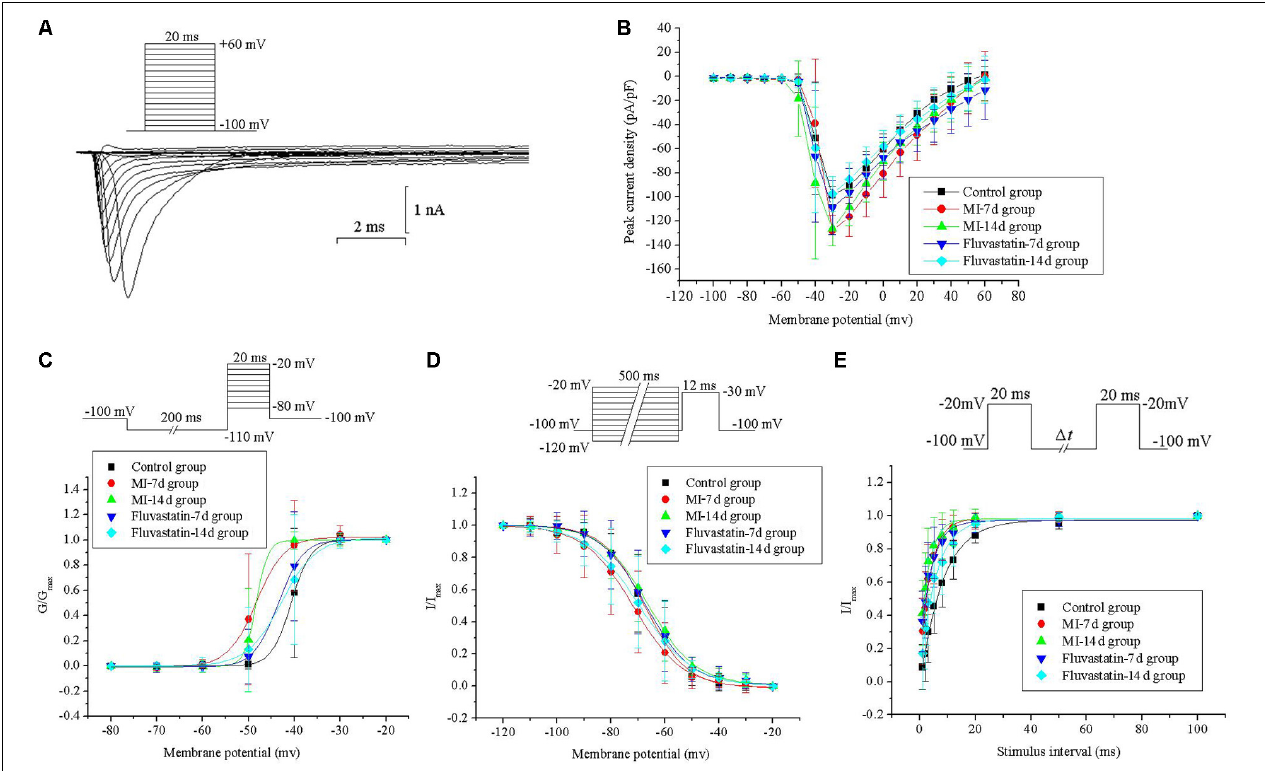
FIGURE 2 | Effects of MI and fluvastatin on I Na of SCG neurons. (A) Typical examples of I Na curves. (B) Effects of MI and fluvastatin on I–V curves of SCG neurons I Na . (C) Effects of MI and fluvastatin on activation process of I Na . (D) Effects of MI and fluvastatin on inactivation process of I Na . (E) Effects of MI and fluvastatin on recovery curves after inactivation of I Na . Each point represents mean ±